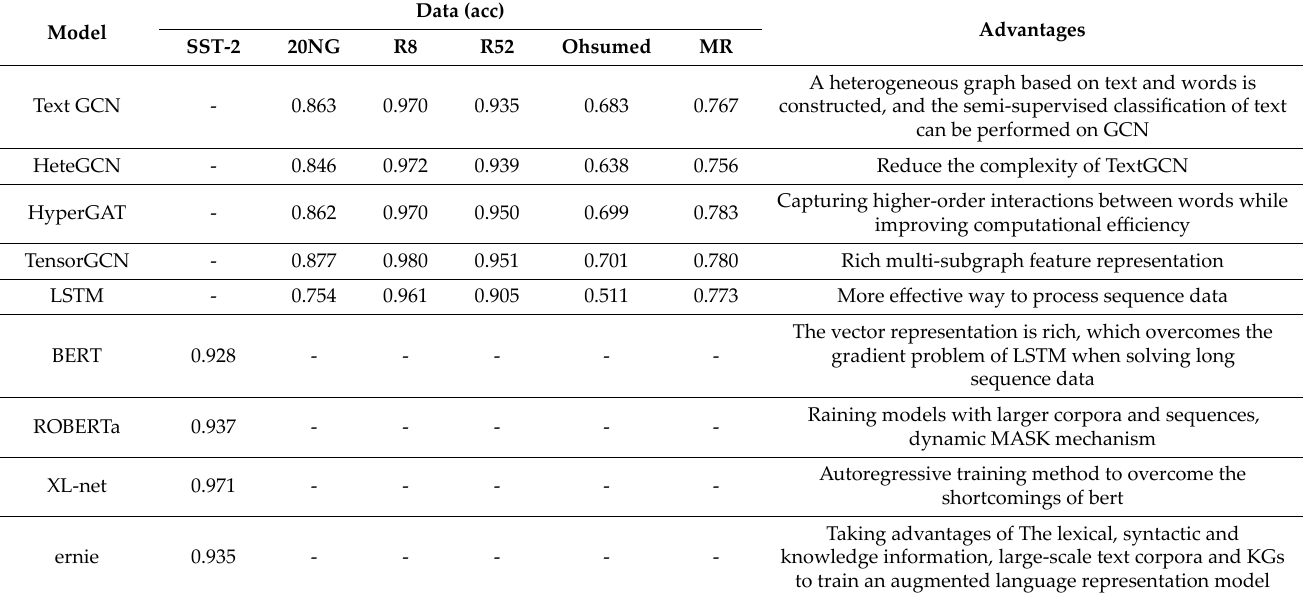
Table 1. Comparison with some